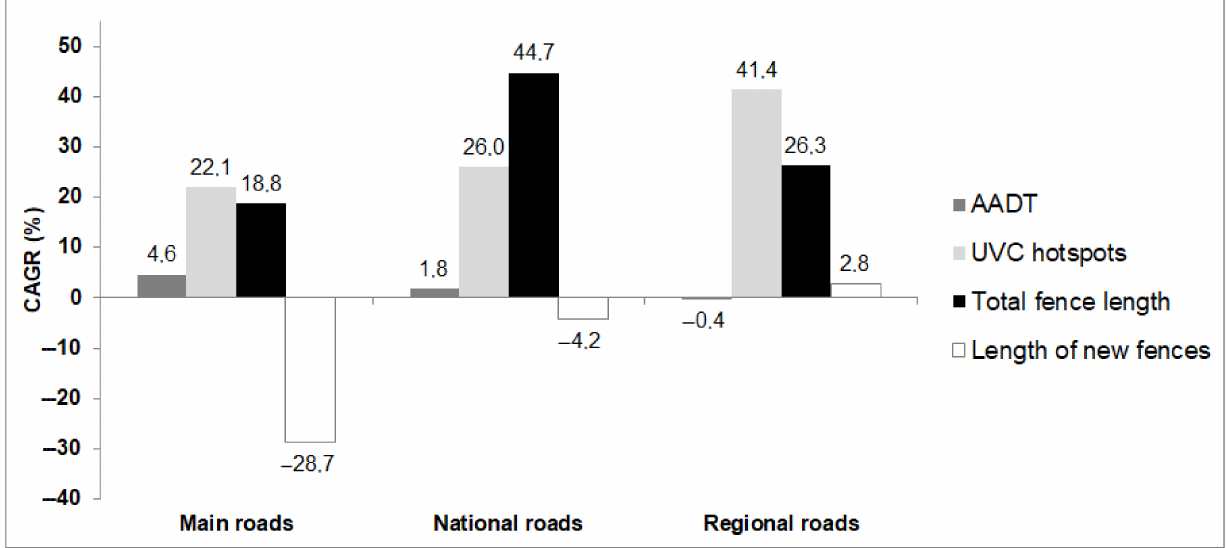
Figure 5. Compound annual growth rate (CAGR) of AADT (Table A1), UVC hotspot (Table A3), and fence length (Table A4) distributions within the different types of road networks in 2002–2017.